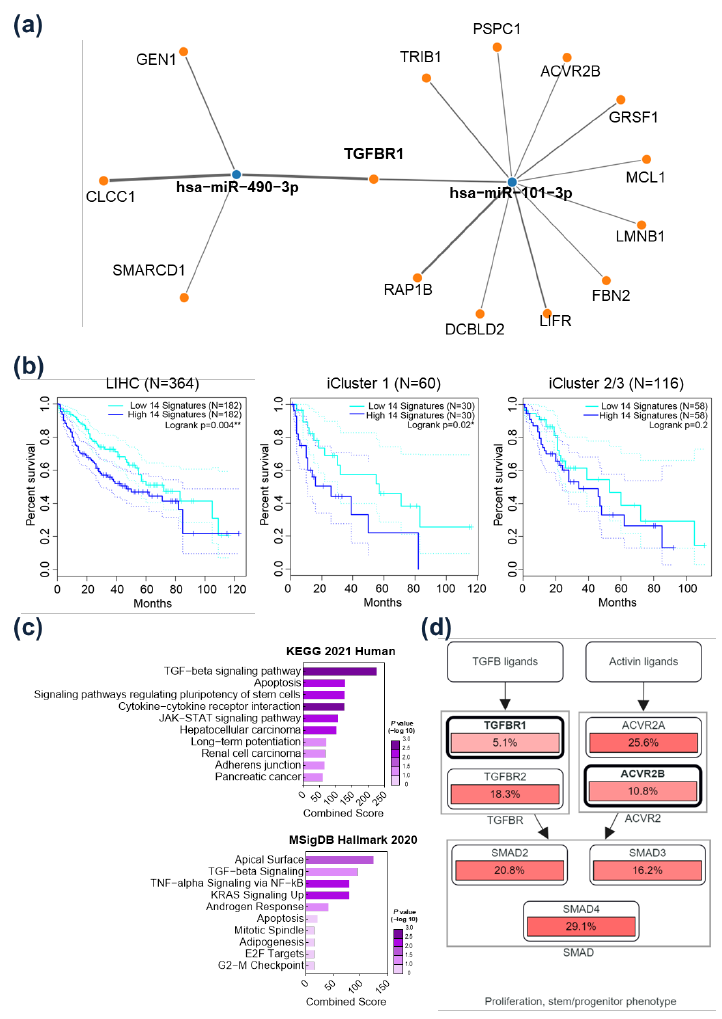
Figure 3. TGFBR1 was identified as a common target gene of hsa-miR-101-3p and hsa-miR-490-3p . ( a ) Possible target gene network of hsa-miR-101-3p and hsa-miR-490-3p predicted by the miRWalks